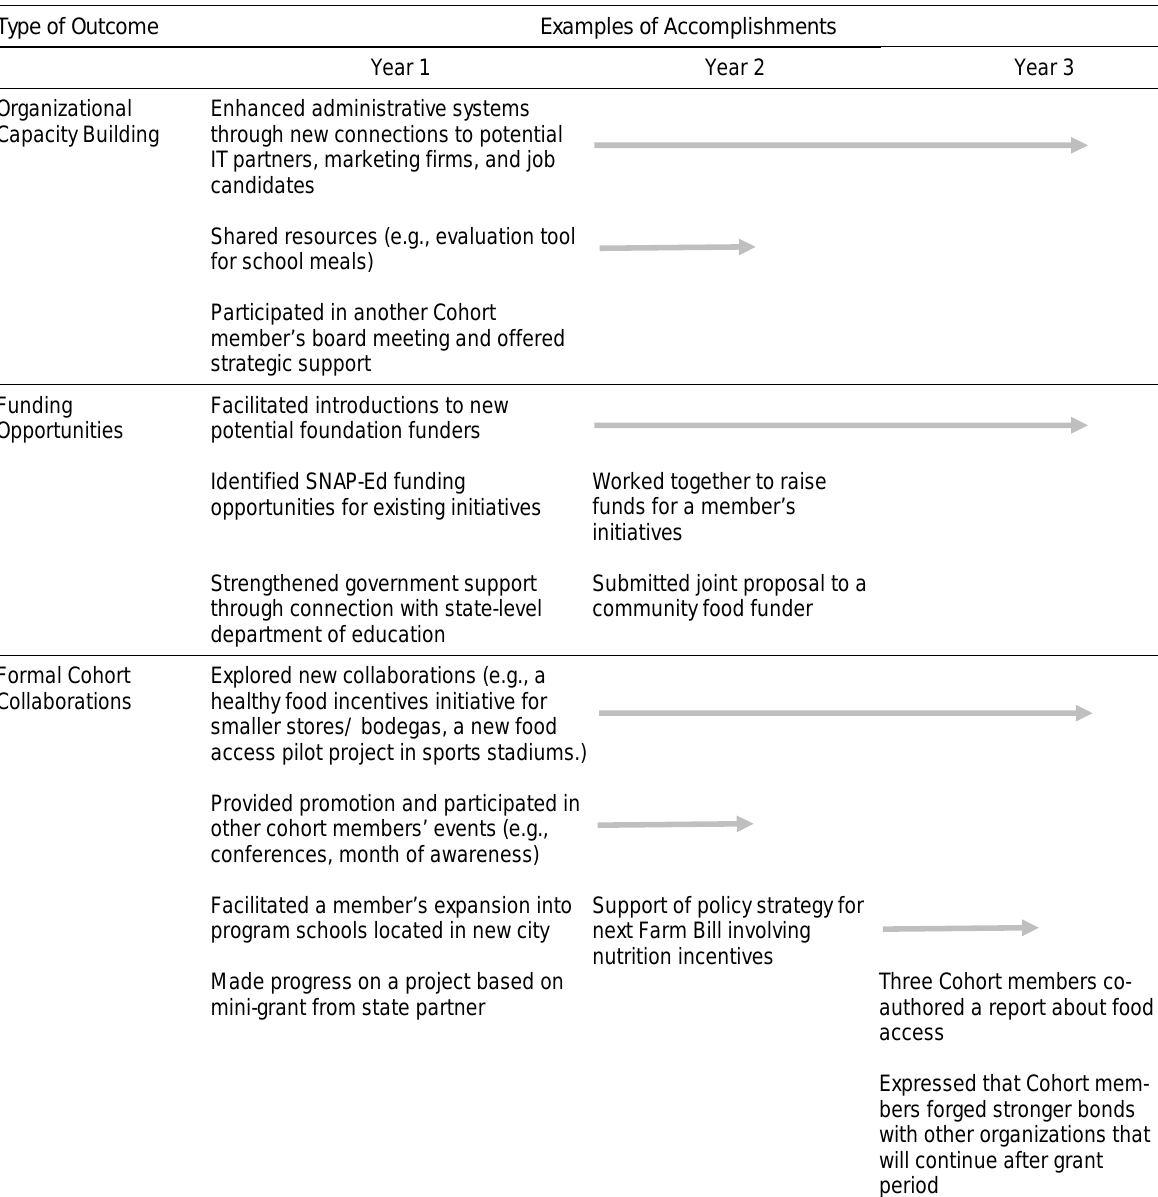
Table 3. Nutrition Cohort Member Accomplishments During Years 1–3 Type of